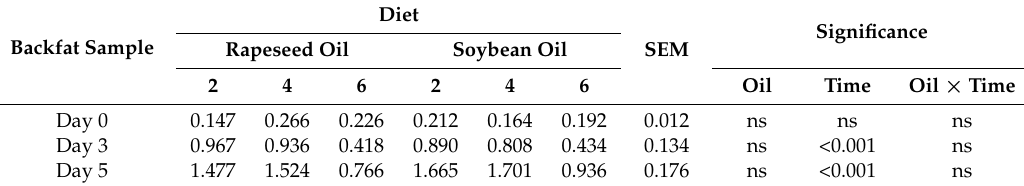
Table 6. Malondialdehyde in backfat (mg